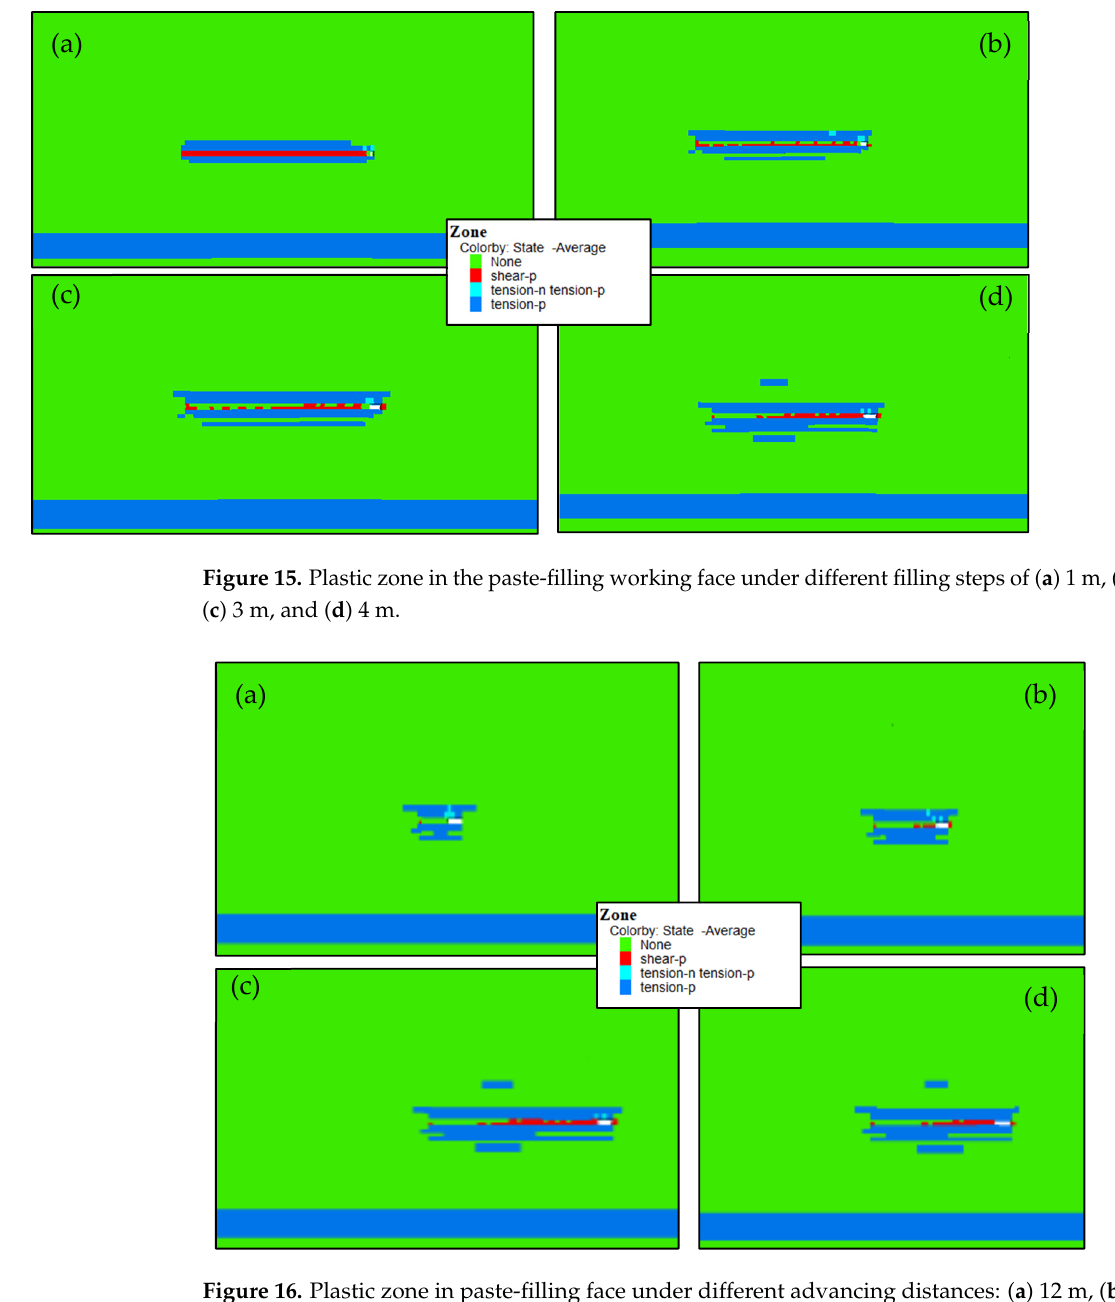
Figure 16. Plastic zone in paste-filling face under different advancing distances: ( a ) 12 m, ( b ) 24 m, ( c ) 36 m. and ( d ) 48 m.